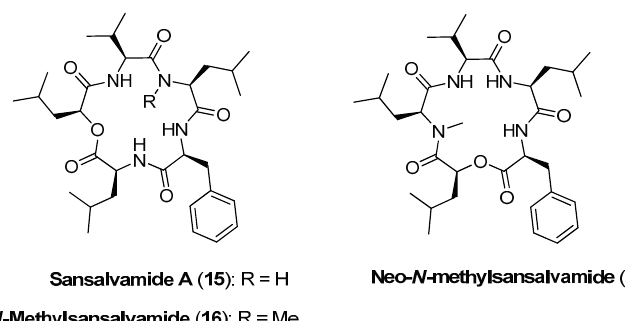
Figure 3. Structures of sansalvamides 15 – 17